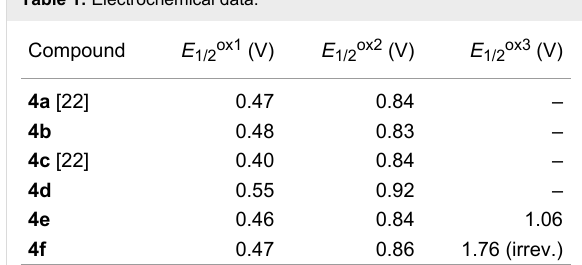
Table 1: Electrochemical data. a